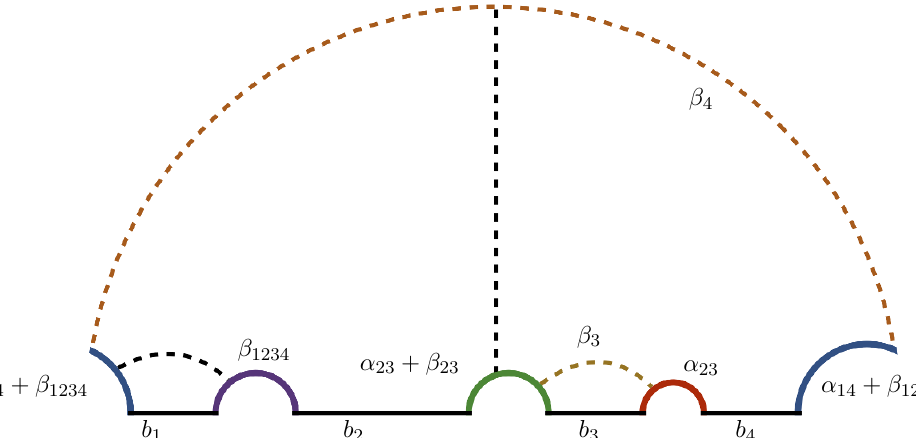
(b) One fourth of the genus 2 Schottky domain, reduced by two symmetries. The two symmetries of the plane are re(cid:13)ection about the x -axis (labeled h 0 ) and the product of the re(cid:13)ection about the y -axis (dashed black) and inversion through the unit circle (labeled (cid:12) 4 ). The boundary cycle h 0 is broken into four segments b i . Figure 14 . Planar representations of the genus 2 Riemann surface considered.